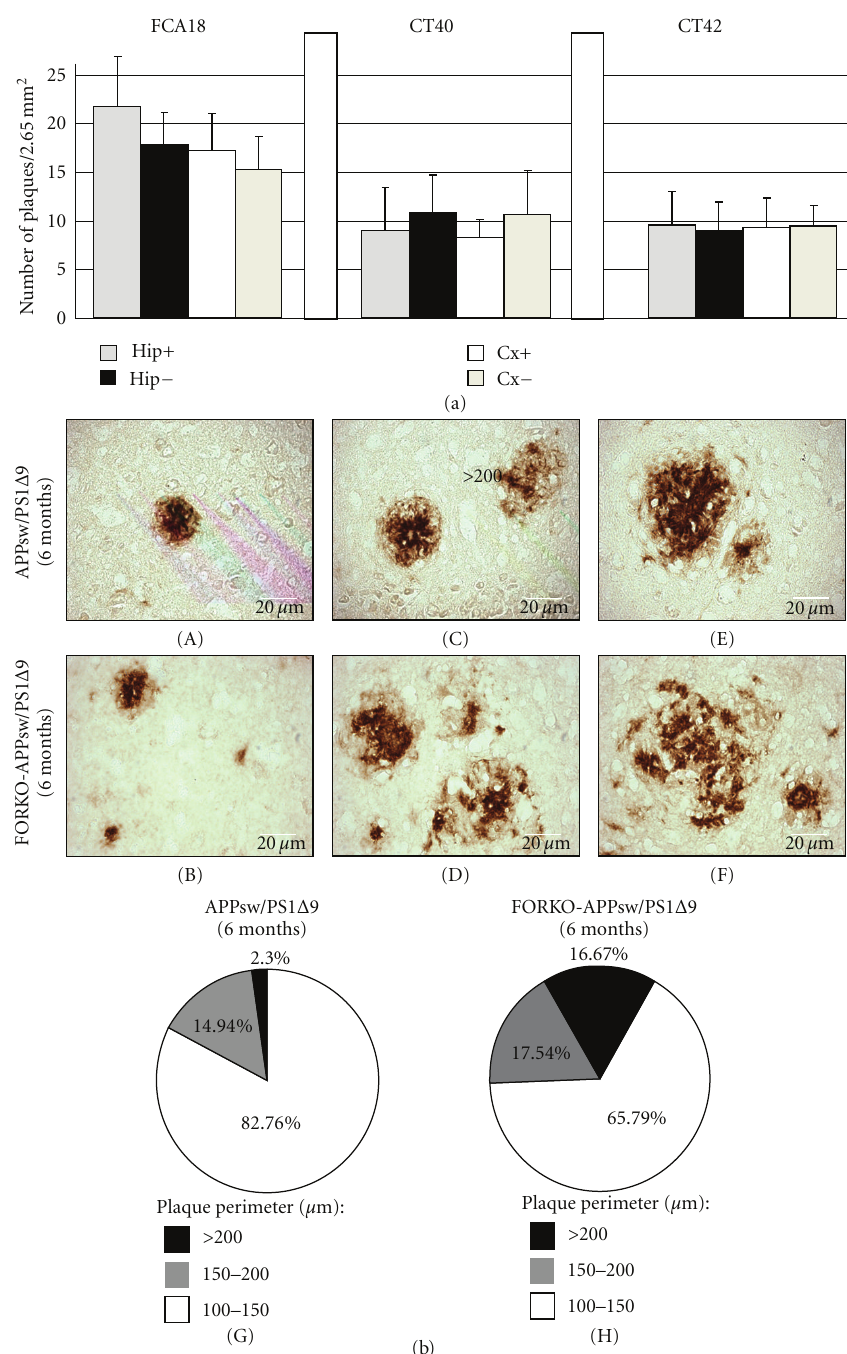
Figure 2: Six-month-old sex-hormone-imbalanced FORKO-APPsw/PS1 9 mice show similar plaque localization and number but dif- (cid:0) 9 alone. (a) Six-month-old sex-hormone-imbalanced ference in plaque appearance and size compared to mice coexpressing APPsw/PS1 (cid:0) FORKO-APPsw/PS1 9 mice show no significant changes in plaques number compared to mice coexpressing APPsw/PS1 9 alone. (cid:0) (cid:0) 9 and FORKO-APPsw/PS1 9 mice were examined by immunocytochemical staining for A β peptide with the polyclonal APPsw/PS1 (cid:0) (cid:0) antibody anti-A β 40/42 (FCA18), anti-A β 40 (CT40), or anti-A β 42 (CT42). Quantification of plaques number was achieved by plaque 9 ( − / − ; n = 6). (b) counting on sagittal brain sections of hippocampus and cortex in APPsw/PS1 Δ 9 (+/+; n = 6) and FORKO-APPsw/PS1 (cid:0) 9 ( n = 6; (A), (C), and (E)) and FORKO- Presented is anti-A β 40/42 (FCA18) immunostaining of sagittal brain sections from APPsw/PS1 (cid:0) APPsw/PS1 Δ 9 ( n = 6; (B), (D), and (F)). By 6 months of age, both mice strains had developed A β plaques in typical areas of the brain, such as ((A) and (B)) the frontal cortex, ((C) and (D)) the parietal cortex, and ((E) and (F)) the hippocampus. Note that many more 9 brains. Scale bar in all panels is 20um. relatively large and di ff use plaques are found in chimeric mice compared to those in APPsw/PS1 (cid:0) ((G) and (H)) Quantification of the plaques perimeter revealed 16.67 % of large, 17.54 % of medium, and 65.79 % of small plaques in 9 (H) compared to 2.3 % of large plaques, 14.94 % of medium and 82.76% of small plaques in APPsw/PS1 9 FORKO-APPsw/PS1 (cid:0) (cid:0)